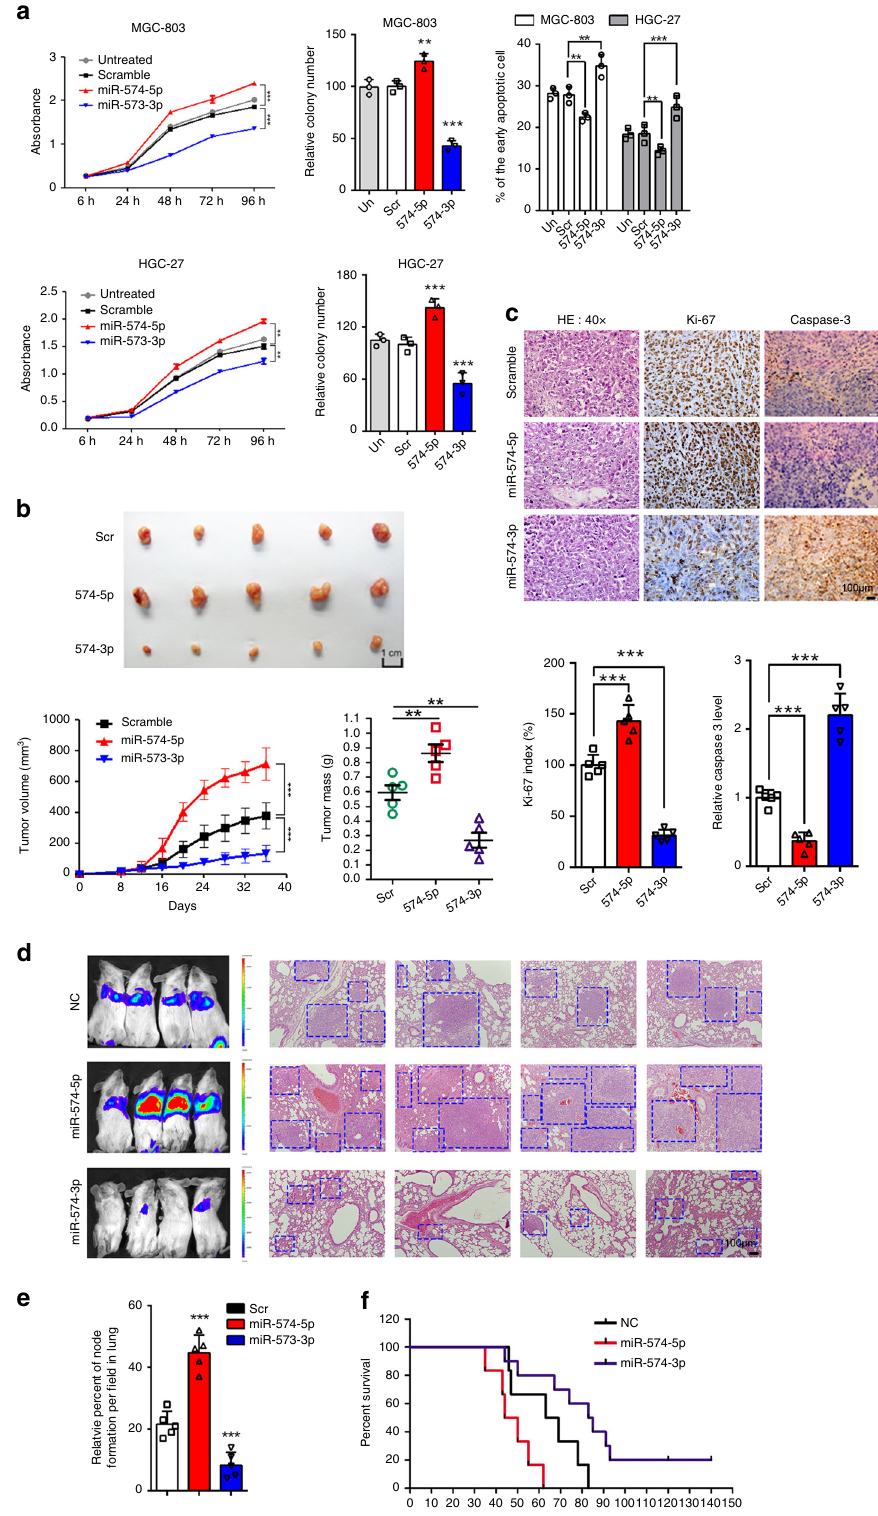
control, while miR-574-3p inhibited the growth of engrafted tumor growth (Fig. 2b). In miR-574-5p mimic treated tumors, tumors (Fig. 2b, Supplementary Fig. 1C). The volumes and proliferation marker Ki-67 was upregulated and apoptotic weights of tumors treated by miR-574-5p mimic were sig- marker caspase-3 was downregulated. The opposite result was ni fi cantly increased than scrambled controls, whereas observed in miR-574-3p group (Fig. 2c, Supplementary those of miR-574-3p mimic treatment resulted in suppressed Fig. 1D). NATURE COMMUNICATIONS| (2019) 10:4397